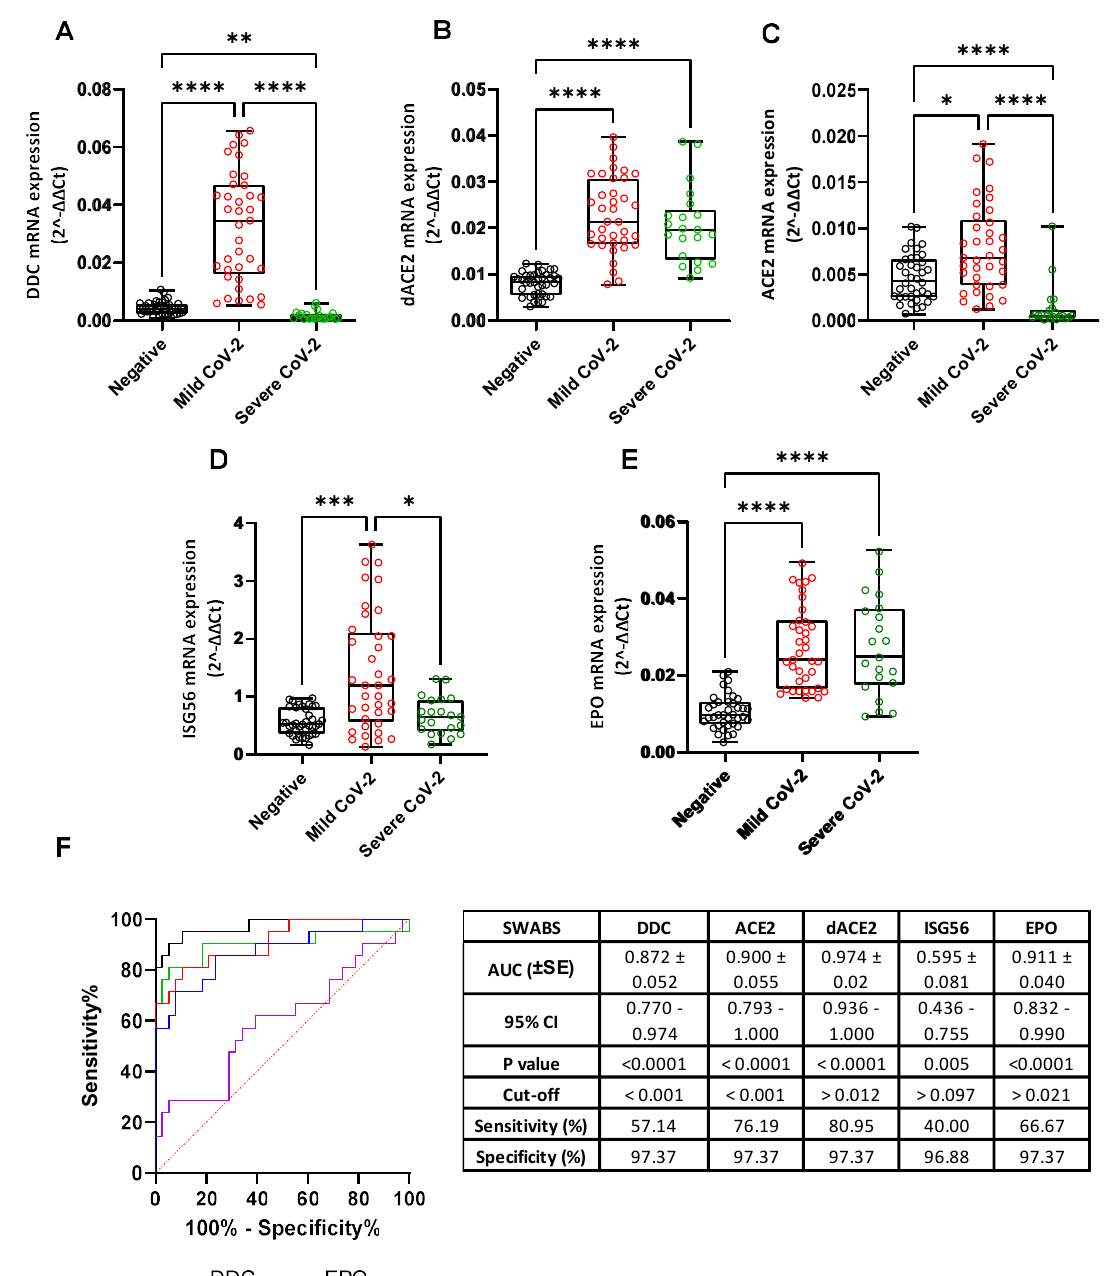
Figure 1. Comparison of DDC ( A ), dACE2 ( B ), ACE2 ( C ), ISG56 ( D ), and EPO ( E ) expression in the nasopharyngeal swab samples of SARS-CoV-2 positive subjects with mild (Mild CoV-2) or severe (Severe CoV-2) symptoms and SARS-CoV-2 negative subjects (Negative). ( F ) ROC curve analysis of the expression of the aforementioned-genes in the Severe CoV-2 cohort. ( A – E ) Data are shown as box plots and dots; the line in the middle corresponds to the median value; box edges, 25th to 75th centiles; whiskers, range of values. The p -values were calculated with the Kruskal–Wallis test. Dunn’s test was performed for multiple comparisons. ROC curves were generated, and AUC, 95% CI, p -values, and cut-off points with their specificity and sensitivity were reported. The red dotted line denotes perfect chance (positive likelihood ratio = sensitivity/(1-specificity). * p < 0.05, ** p < 0.01, *** p < 0.001, **** p < 0.0001 vs. Negative or Mild